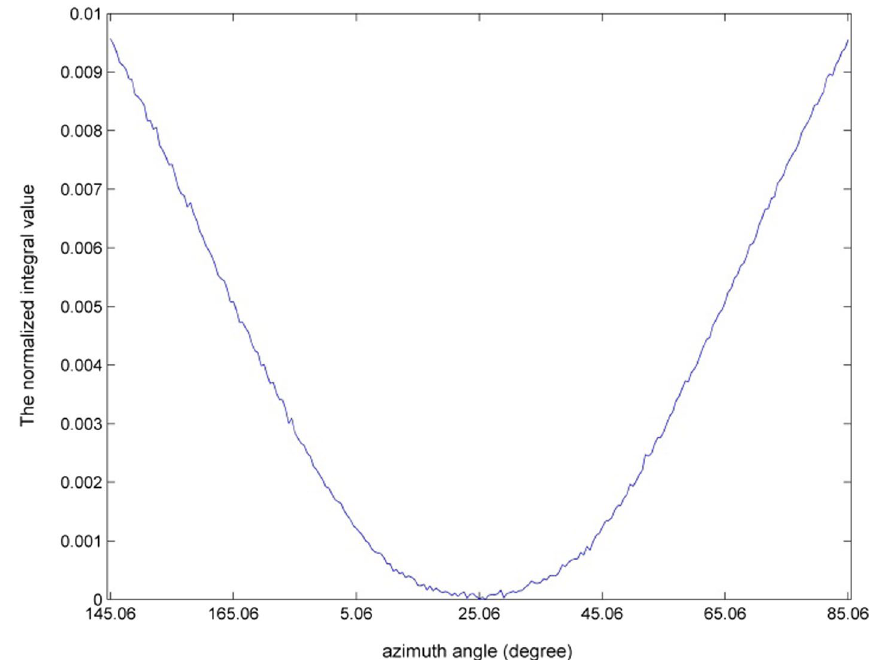
Fig. 2 The normalized LRT of the image in Fig.